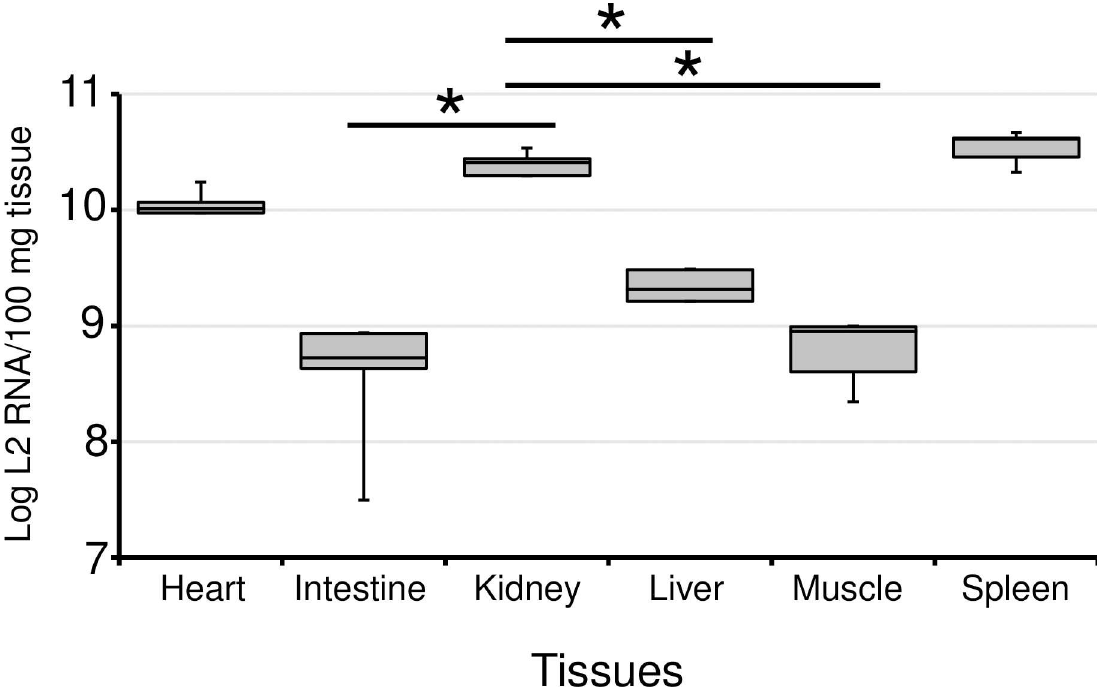
Fig 5. Comparison of the viral RNA loads in different tissues in week 2 of EIBS epizoosis. Viral RNA loads are shown as the copy number of L2 RNA per 100 mg of tissue. Box plots show median, 25th, and 75th percentiles, and whiskers represent minimum and maximum values. ANOVA with the Tukey–Kramer method was used to confirm significant differences in copy numbers. The viral RNA load was significantly higher ( p < 0.05) in the kidney tissue than in the intestine, liver, or muscle